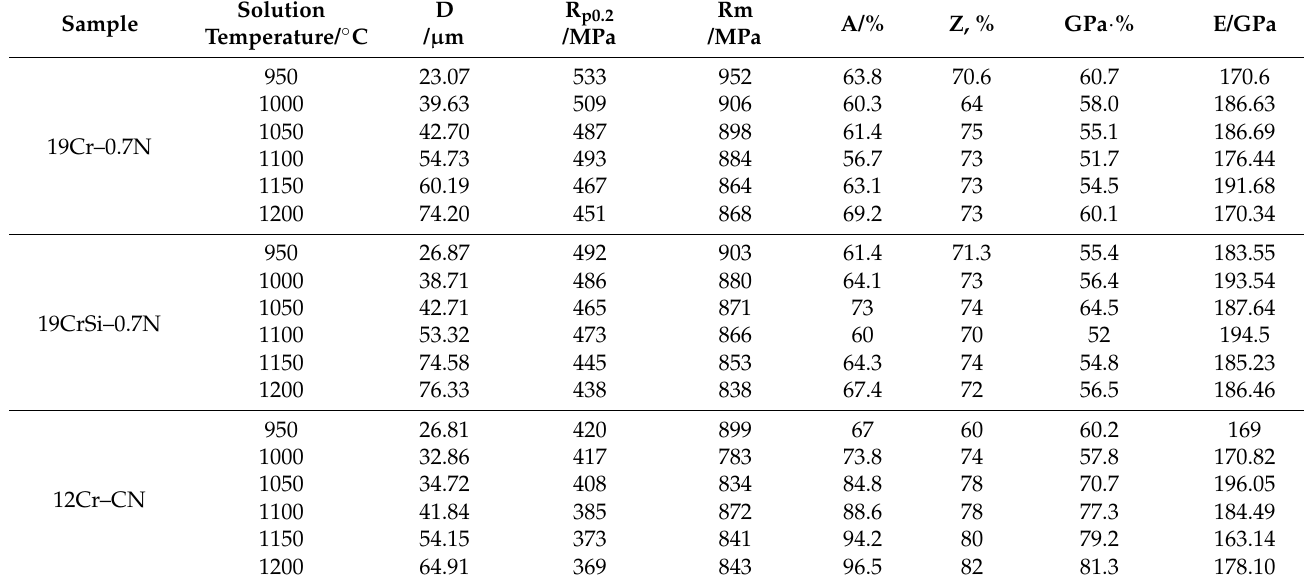
Table 3. Performance parameters of samples at different heat-treatment